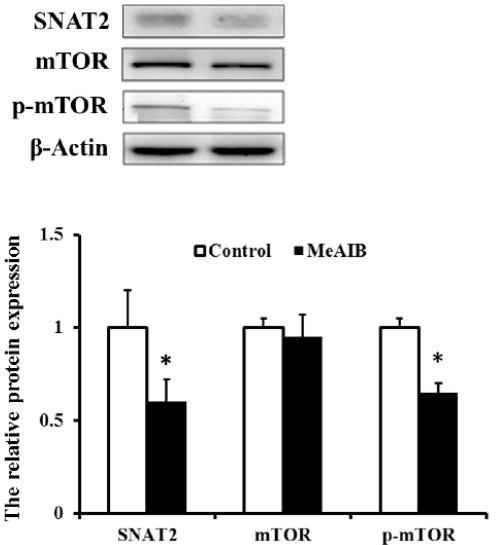
Figure 1. MeAIB induces the inhibition of SNAT2 and mTOR phosphorylation in IPEC-J2 cells. Data are expressed as mean ± Standard Deviation (SD), n = 4 independent experiments. * p < 0.05 versus control treatment.